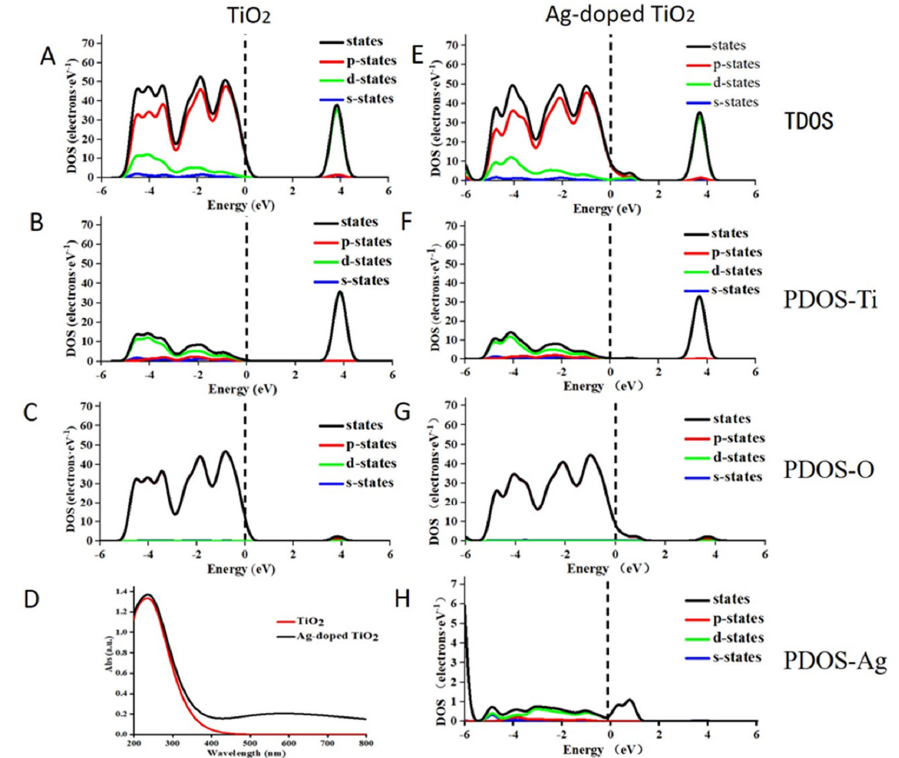
Figure 7. The total density of states (DOS) and the partial density of states (PDOS) for the pro- jected states of Ti, O, and Ag corresponding to TiO 2 ( A – C ) and Ag-doped TiO 2 ( E – H ), and the calculated optical absorption spectrum of TiO 2 and Ag-TiO 2 ( D ) obtained through density functional theory